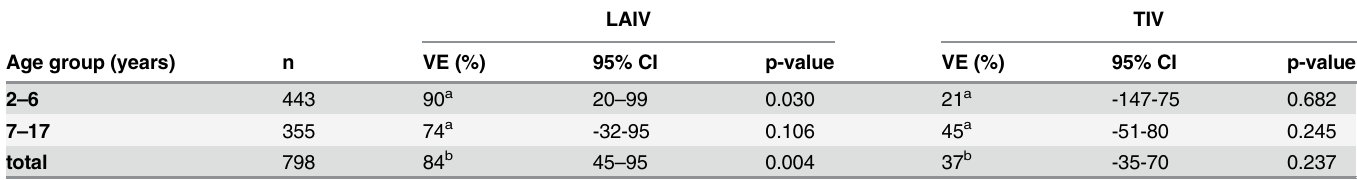
Table 5. Vaccine effectiveness of live (LAIV) and inactivated vaccines (TIV) against laboratory-confirmed influenza of all subtypes, stratified by age groups; Multivariable logistic regression, Virological Surveillance, Saxony-Anhalt, Germany 2012/13 (n = 798). LAIV TIV Age group